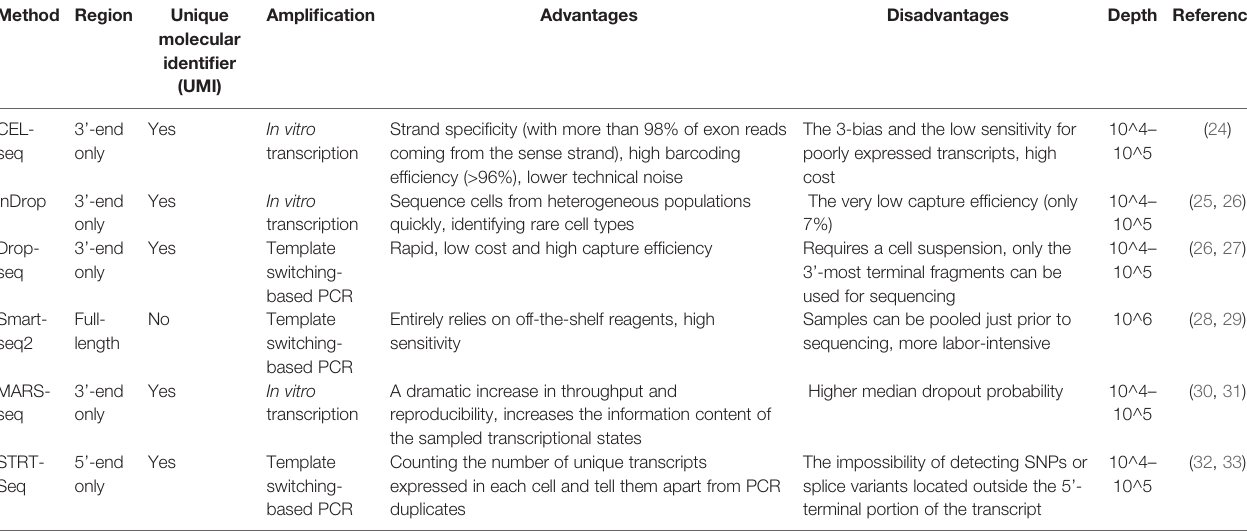
TABLE 1 | Commonly used single-cell sequencing methods and their advantages and